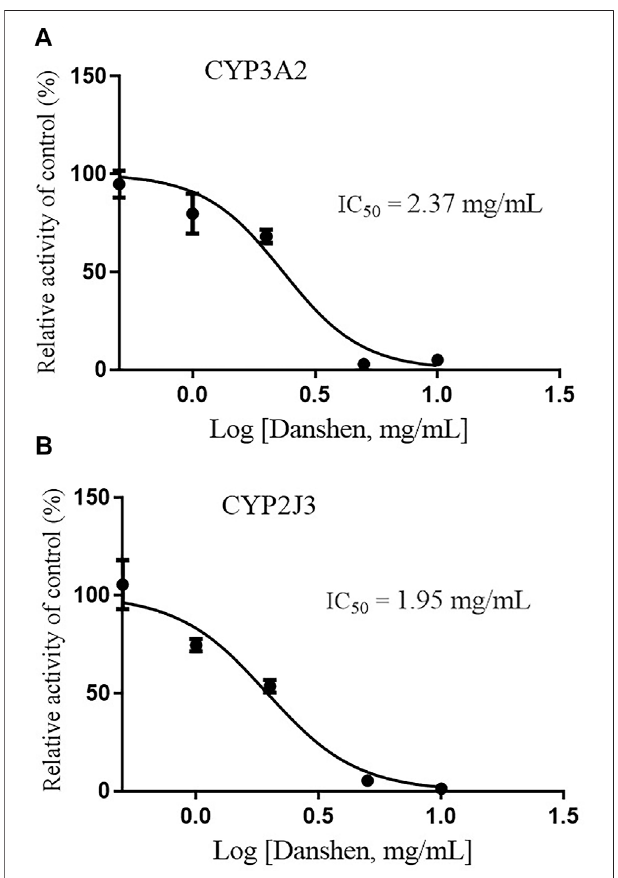
FIGURE 5 | Inhibition of CYP3A2 (A) and CYP2J3 (B) activities by Danshen tablet (0.5 – 10 mg/mL) in RLM. Values are expressed as mean ± SD of quadruplicate assays. The data were fi t to log (Danshen concentration) and normalized response equations using GraphPad Prism